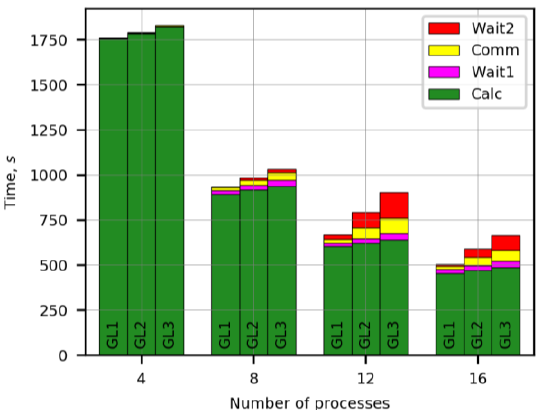
Figure 8. Contribution of computation, communication, and waiting to the benchmark execution times.